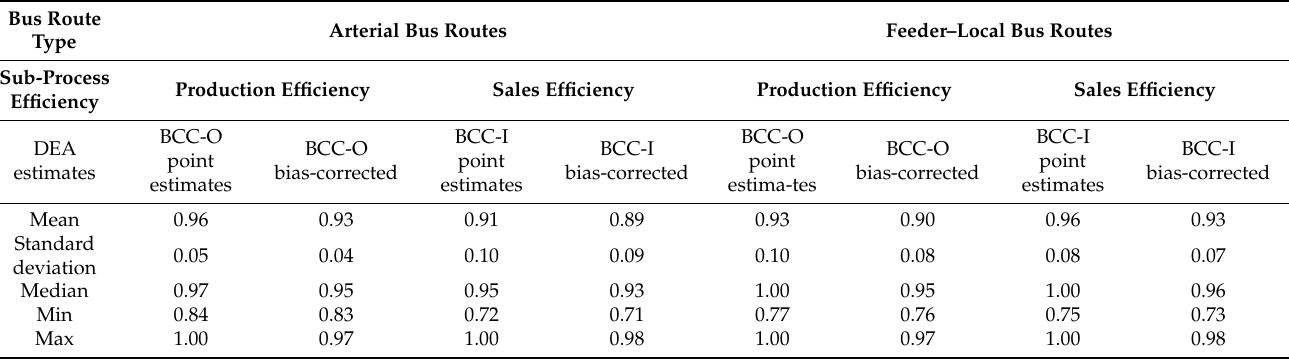
Table 3. Descriptive statistics of arterial vs. feeder–local bus route efficiency measures for production and sales process. Bus Route